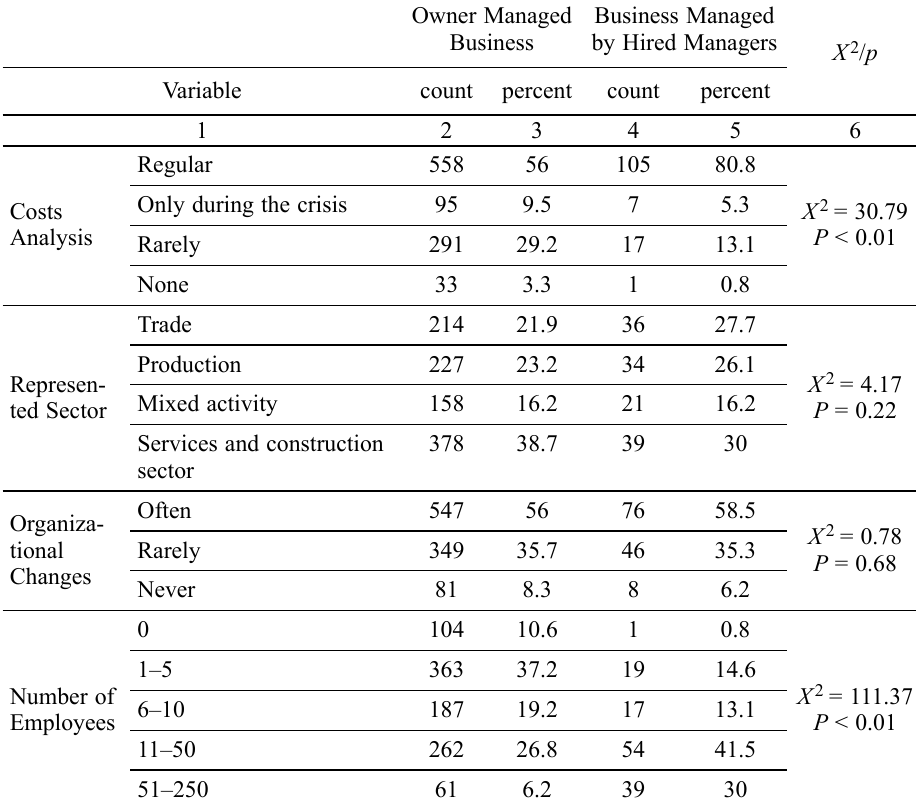
Table 3. Cross-sectional analysis and the results of Pearson X 2 test for the research